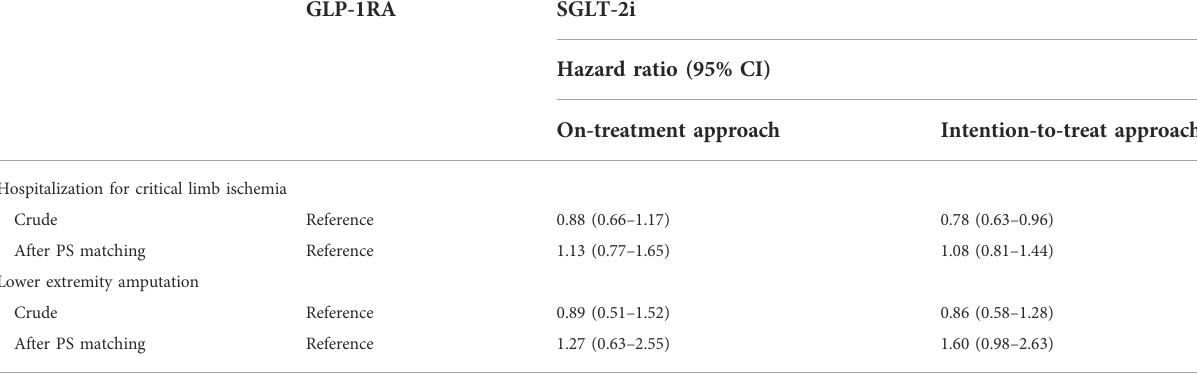
TABLE 2 Hazard ratios of hospitalization for critical limb ischemia and lower extrimity amputation comparing sodium-glucose cotransporter type-2 inhibitor (SGLT-2i) versus glucagon-like peptide 1 receptor agonist (GLP-1RA) initiators. GLP-1RA